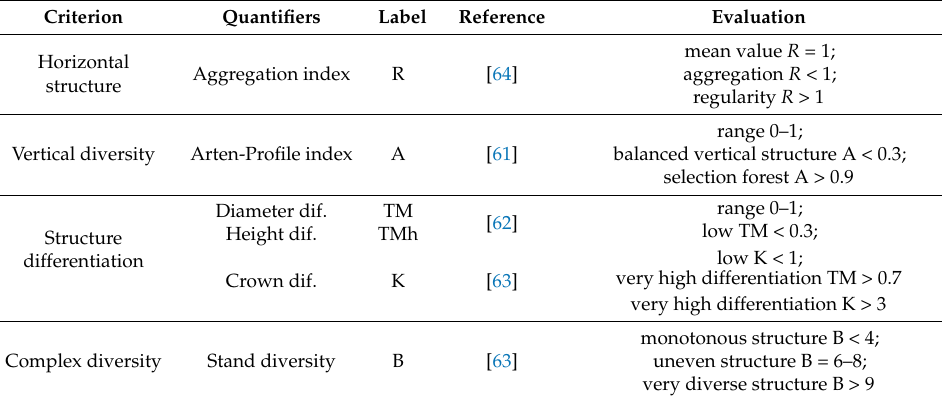
Table 1. Overview of indices describing the biodiversity and their common